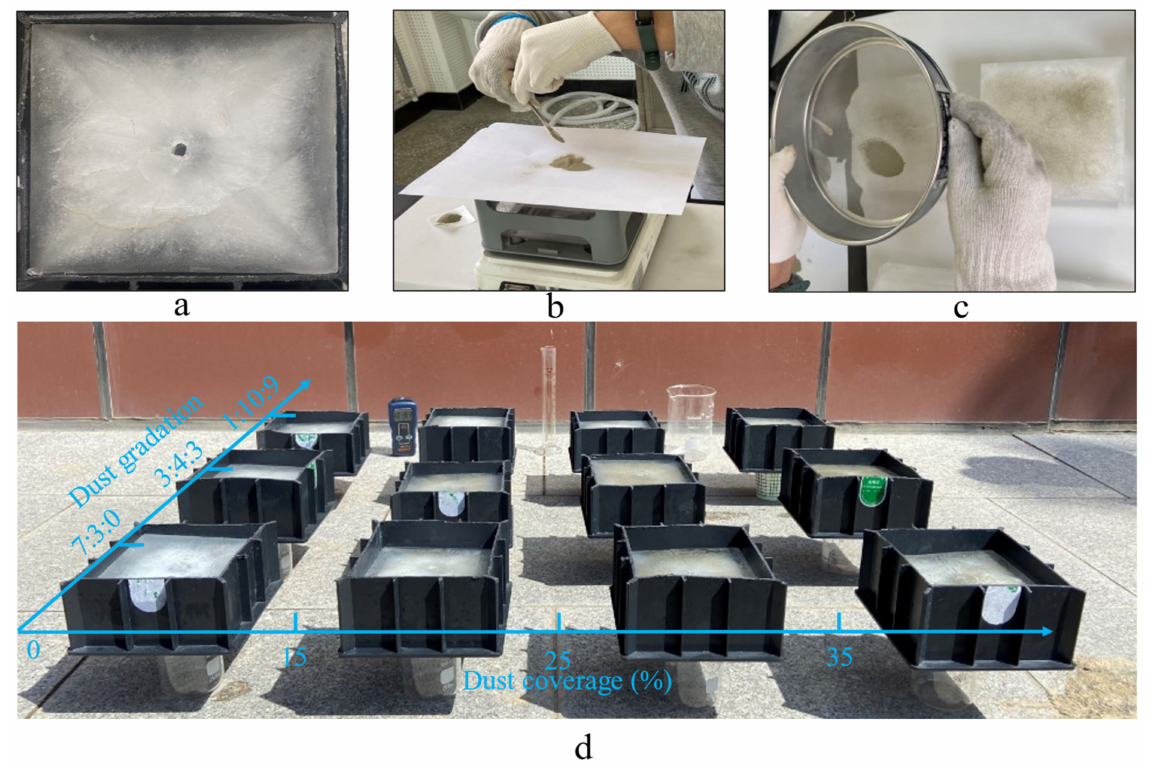
Figure 5. The operation process of the whole ablation experiment, ( a ) ice preparation; ( b ) mineral dust preparation; ( c ) layout of mineral dust; ( d ) ablation experiments were